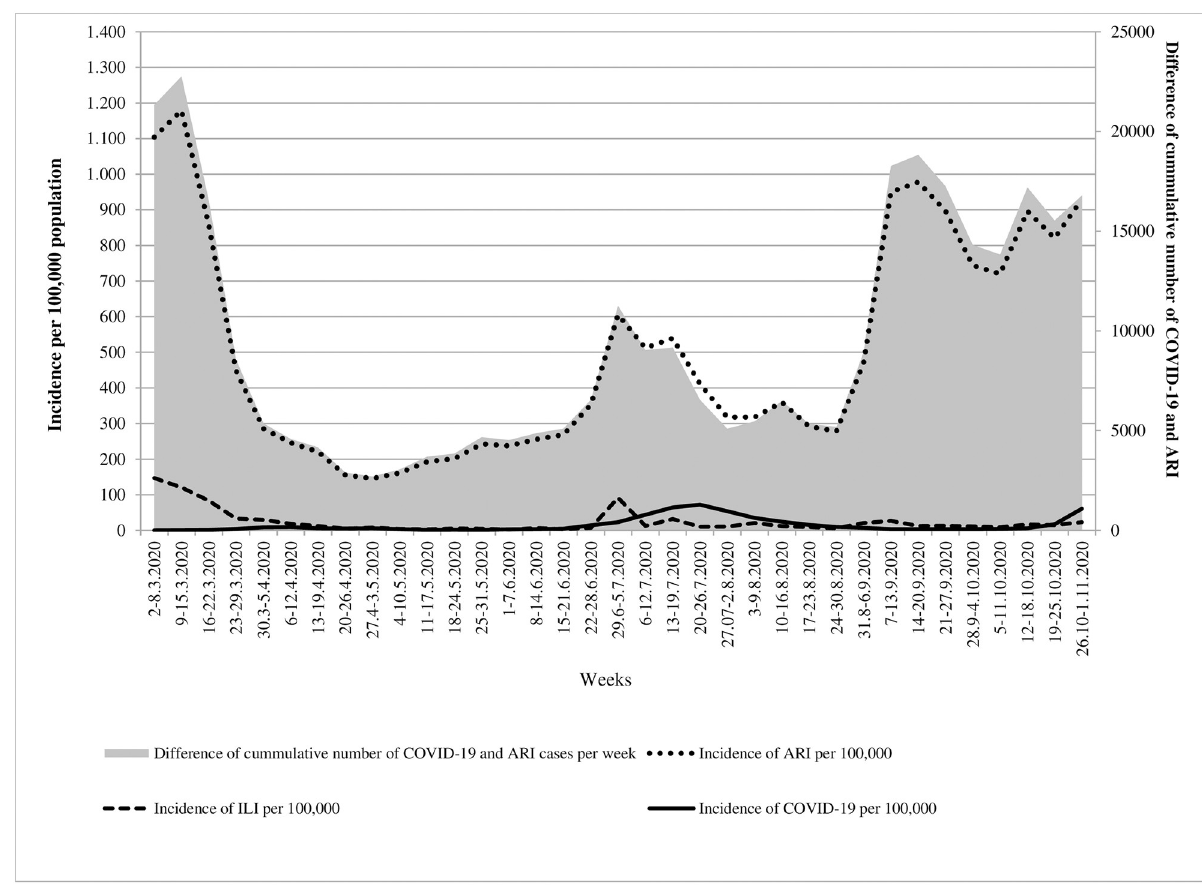
Fig 2. Overview of the three different surveillance systems among patients with symptoms related to COVID-19 between March and October 2020 in Vojvodina, Serbia. ARI: acute respiratory infection; ILI: influenza-like illness.